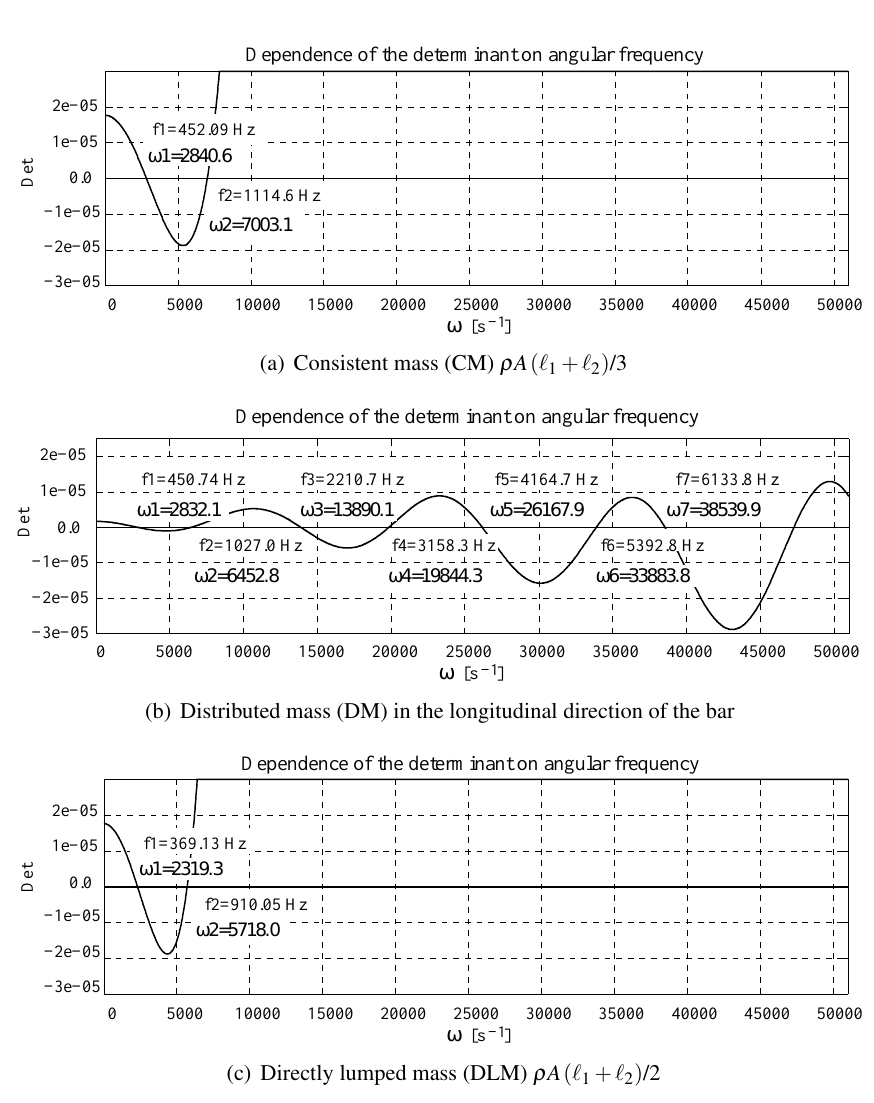
Fig. 8. Natural frequencies of the truss